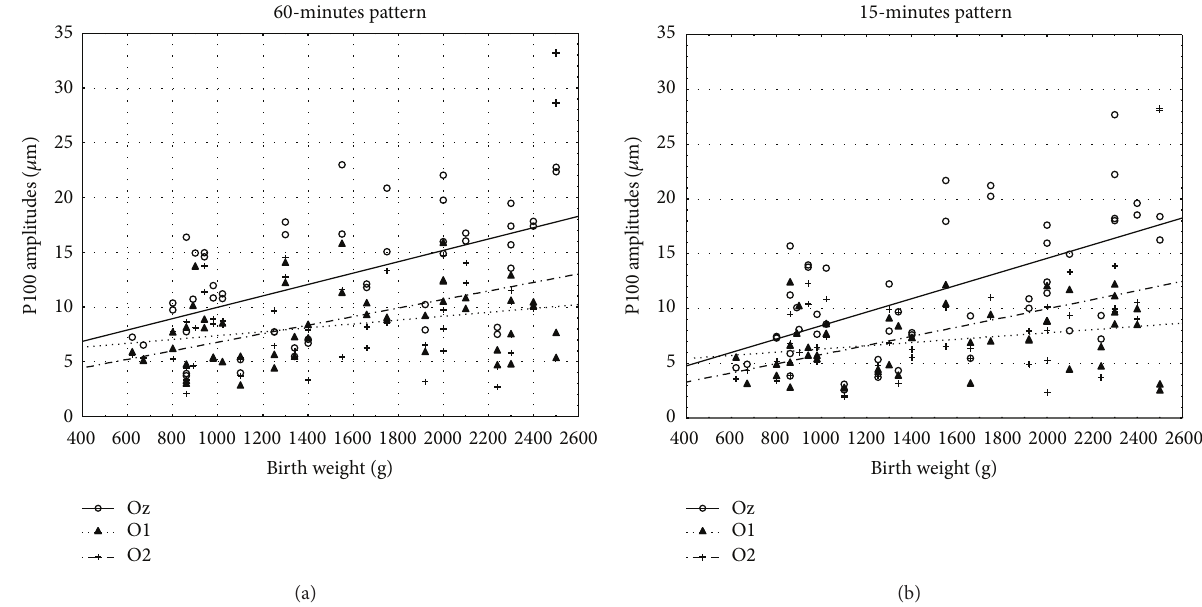
Figure 5: Scatter diagram showing a positive linear correlation between P100 amplitudes ( 𝜇 m) and birth weight (grams) in 15- and 60-minute pattern